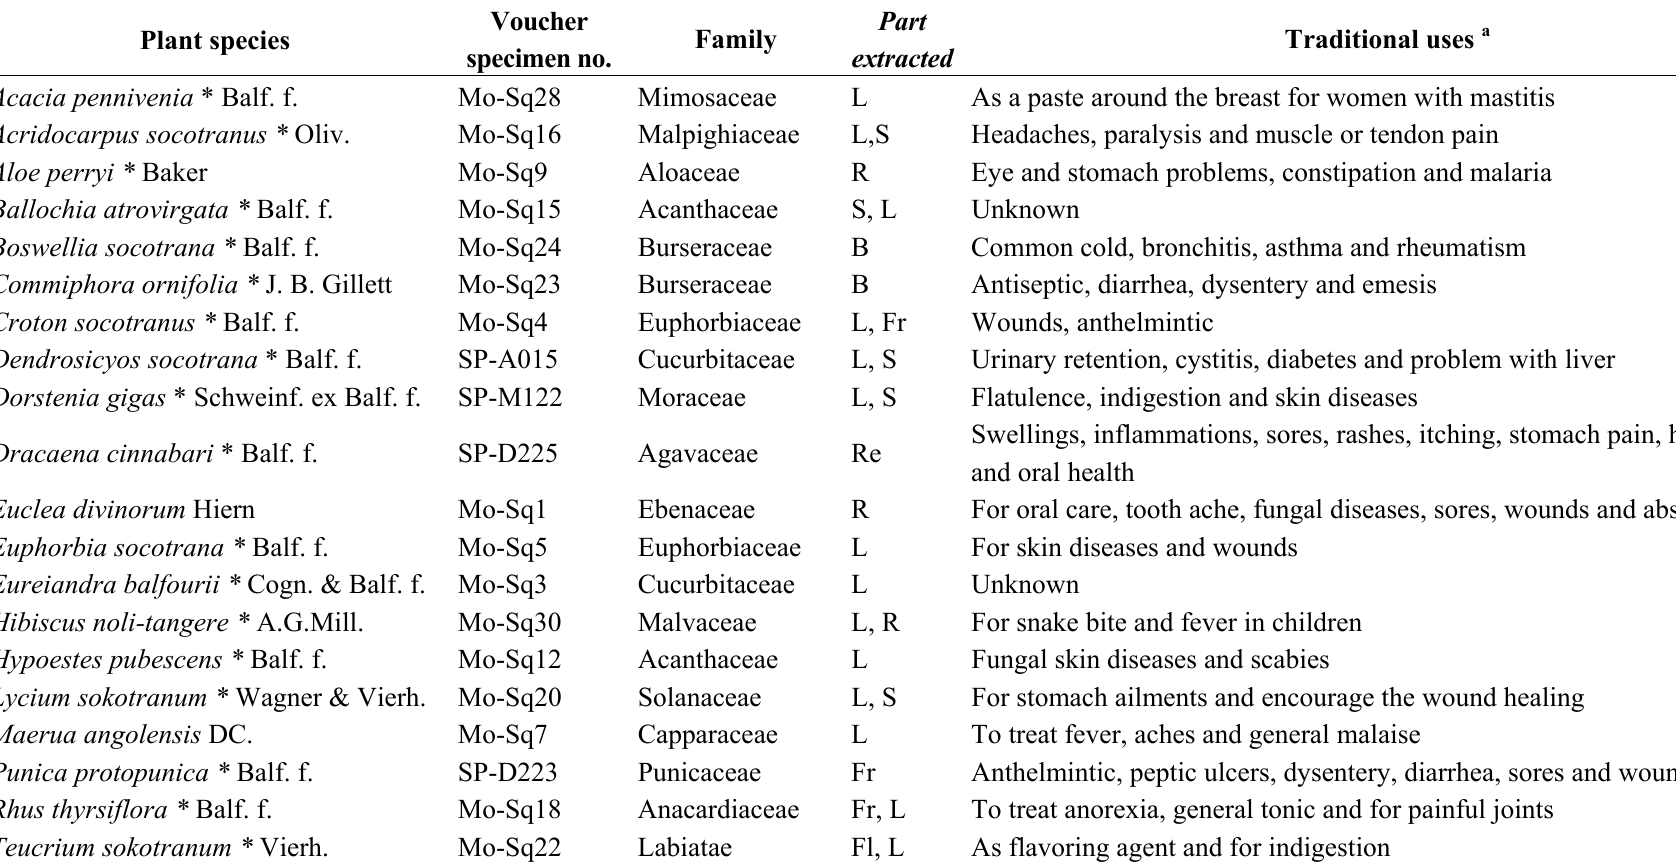
Table 1. List of plants from the island of Soqotra that were screened in the study for antiprotozoal